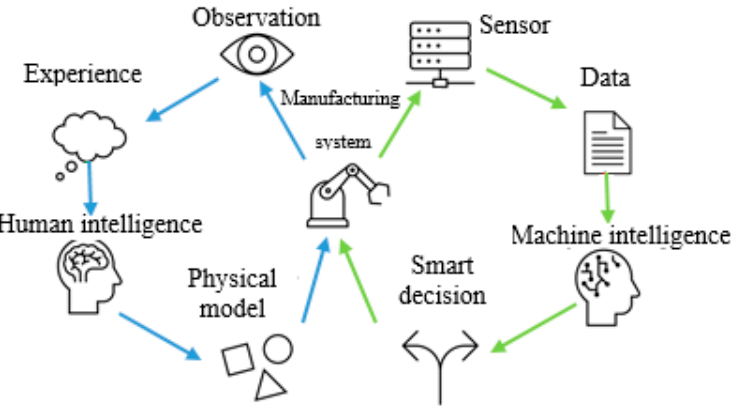
Figure 3. Model-controlled production process vs. data-driven production process (Own processing [17]).